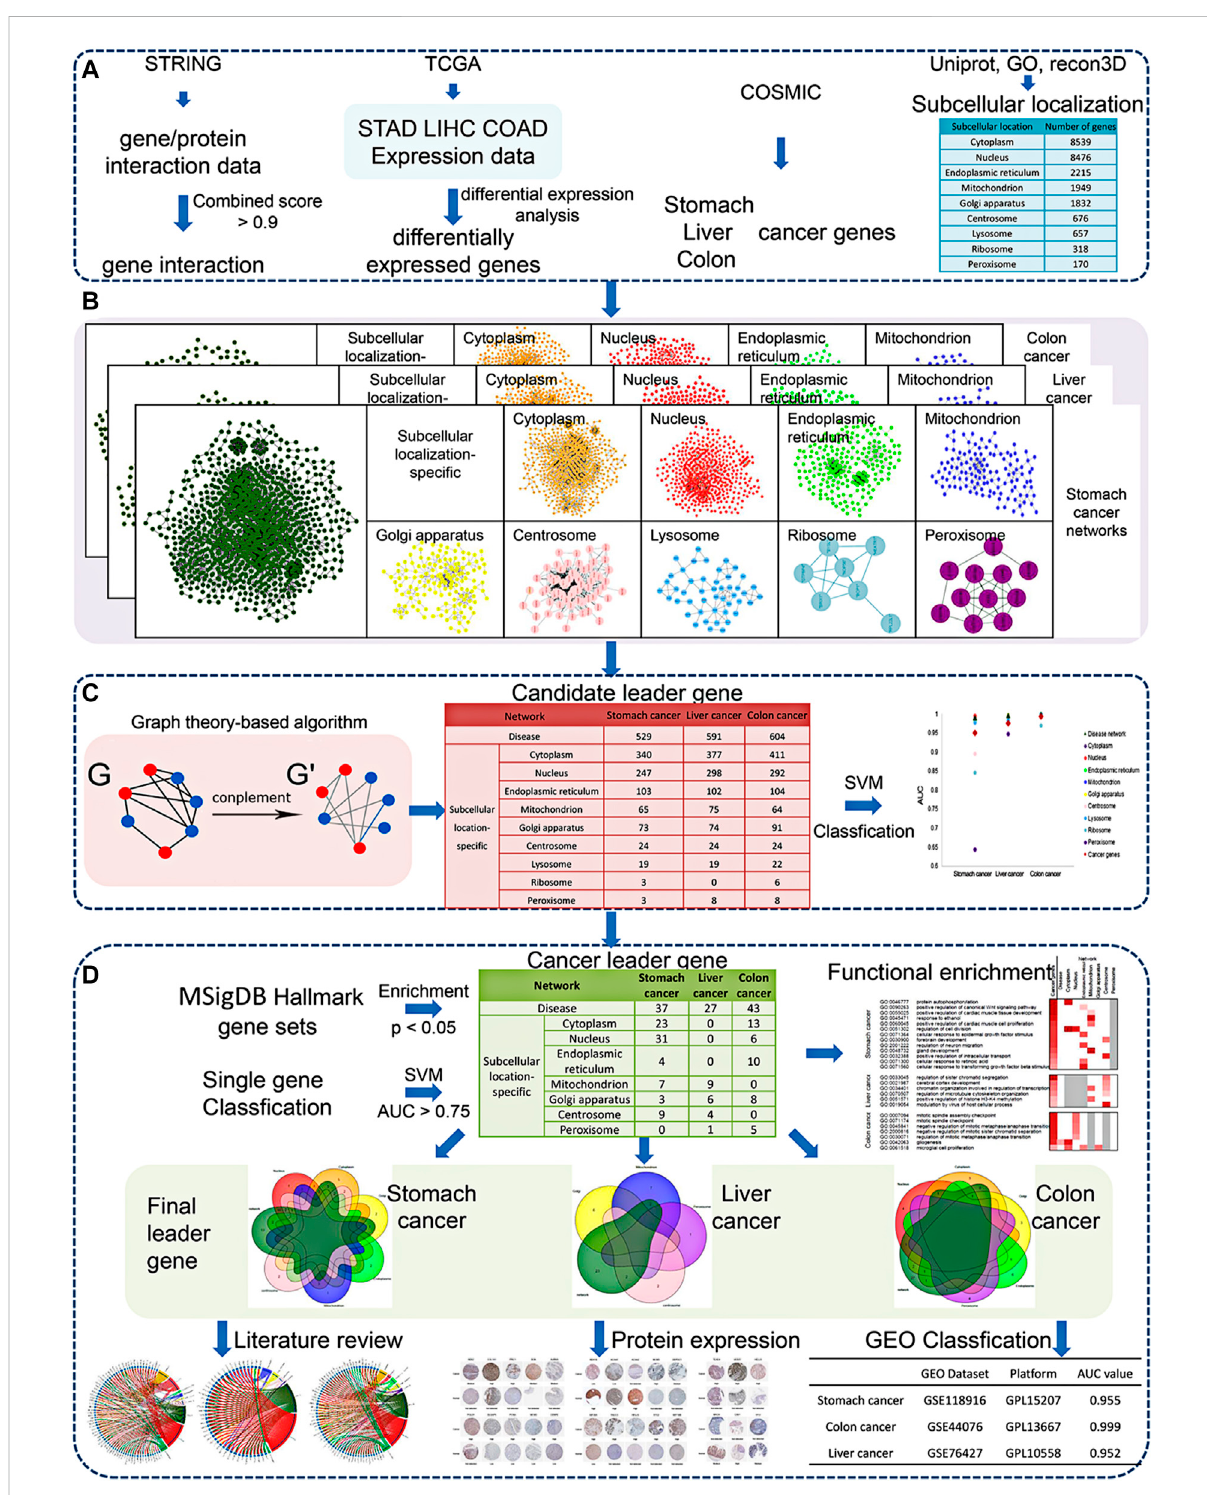
FIGURE 1 Work fl ow of our methodology. (A) Data sources. (B) Disease network construction. (C) Candidate leader gene recognition. (D) Leader gene identi fi cation and